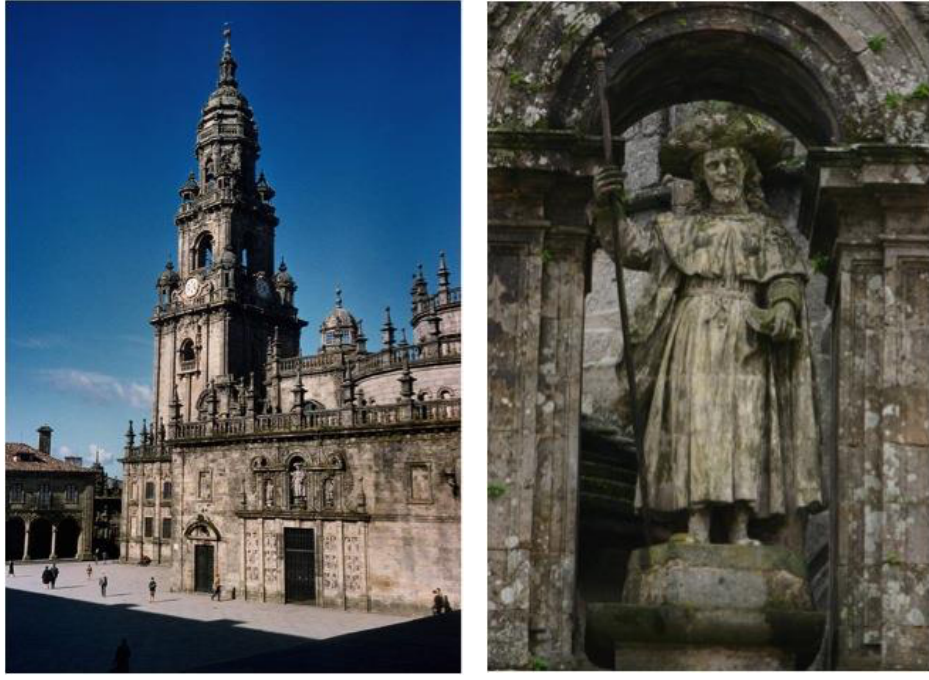
Figure 15 Door) (photo, 1960: William Keighley, ARTstor). Figure 16